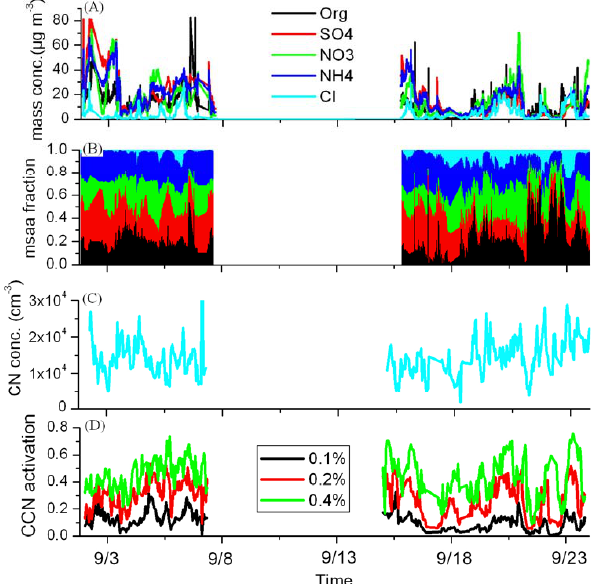
Fig. 1. The mass concentration (A) , mass fraction (B) of aerosol Fig.1 The mass concentration (A), mass fraction (B) of aerosol particles observed by 3 particles observed by AMS, CN number concentration (C) , and the AMS, CN number concentration (C), and the CCN activation (CCN/CN) (D) of aerosols 4 during the experiment 5 CCN activation (CCN/CN) (D) of aerosols during the experiment. 6 observed by SMPS range from 2416 to 32 396 cm − 3 with averaged value of 13117 ± 4797 cm − 3 . The averaged num- ber concentrations of CCN under SS of 0.1 %, 0.2 %, 0.4 % are 1489 ± 982 cm − 3 , 4121 ± 2725 cm − 3 , 6640 ± 6791 cm −